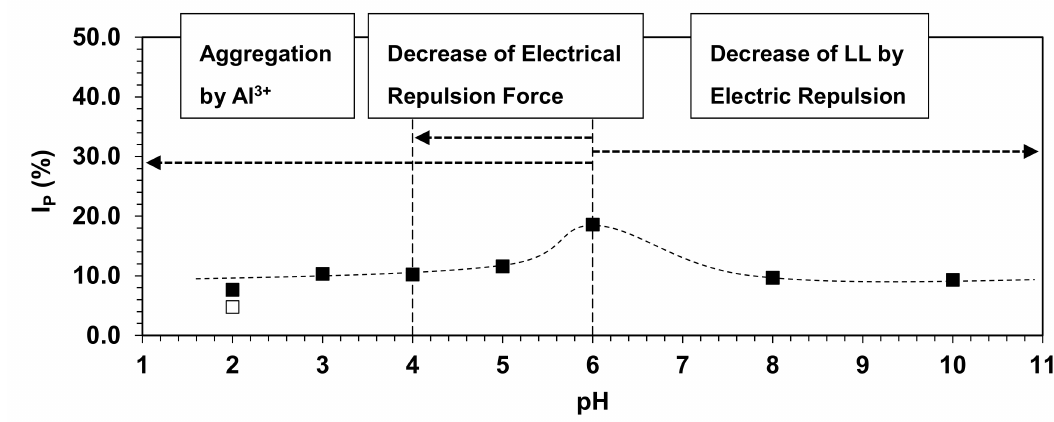
Figure 9. Summary of the effects of different pH conditions on the change of I P of the simulated